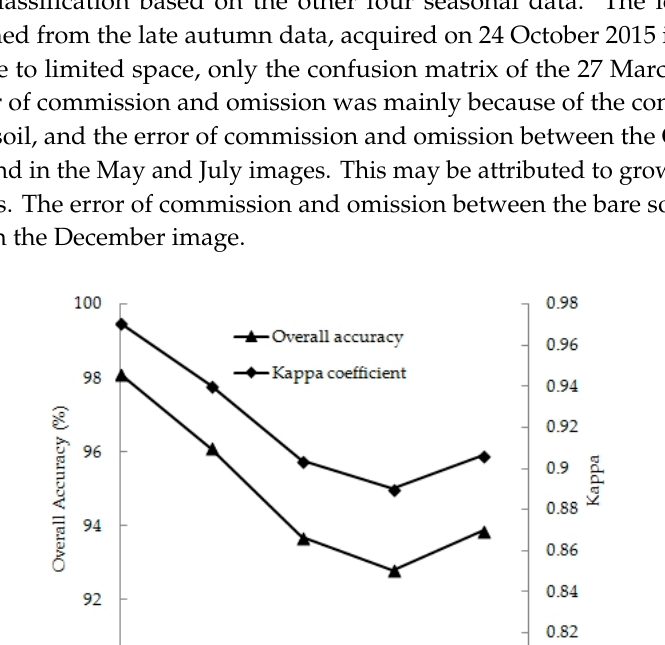
Table 3. Variable selection results for the final RF classification model for the five single season datasets.